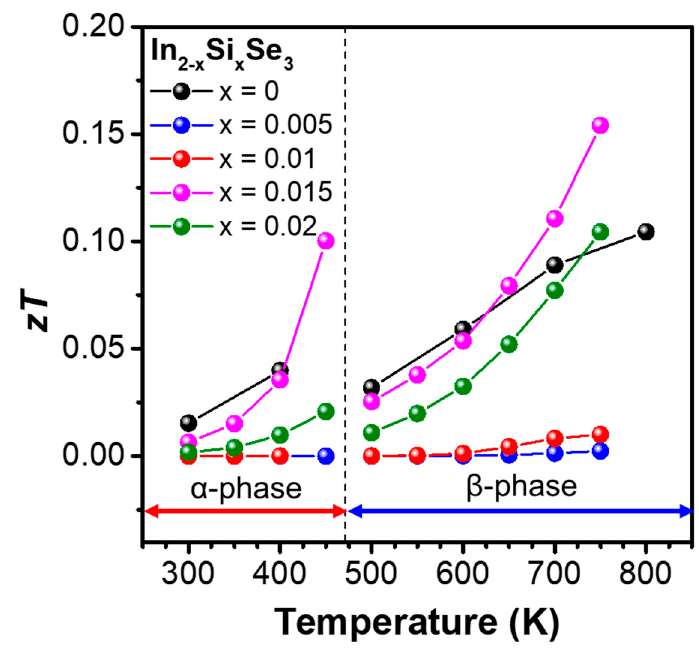
Figure 5. Thermoelectric figure of merit as a function of temperature for the In 2 − x Si x Se 3 ( x = 0, 0.005, 0.01, 0.015, and 0.02) samples.